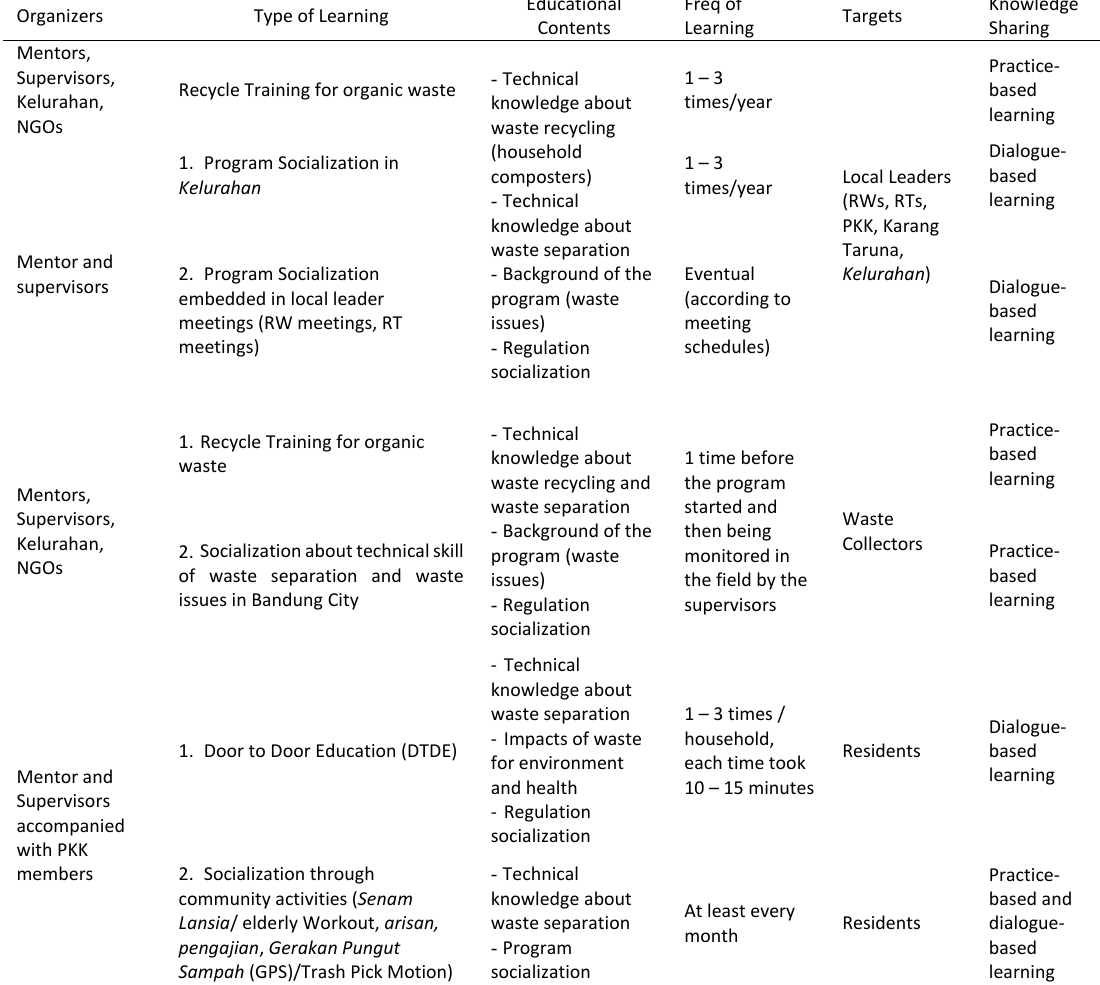
Table 5: Profile of Non-group Learning Activities in KBS Program